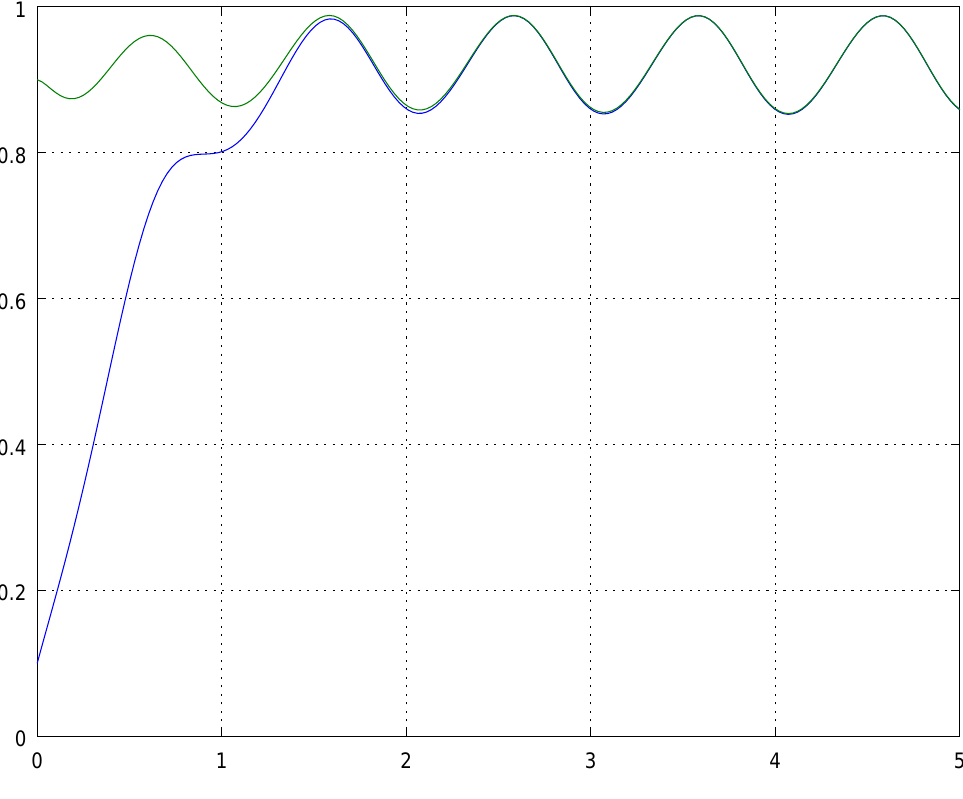
Figure 1. Pr ( X 1 ( t ) = 0 ) under initial conditions (i) and (ii).